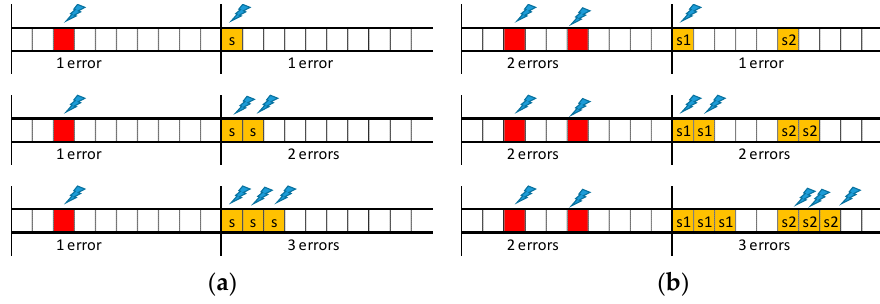
Figure 5 . Scenarios with 1 error ( a ) and with 2 errors ( b ) and retransmission with 1 to 3 replicas.